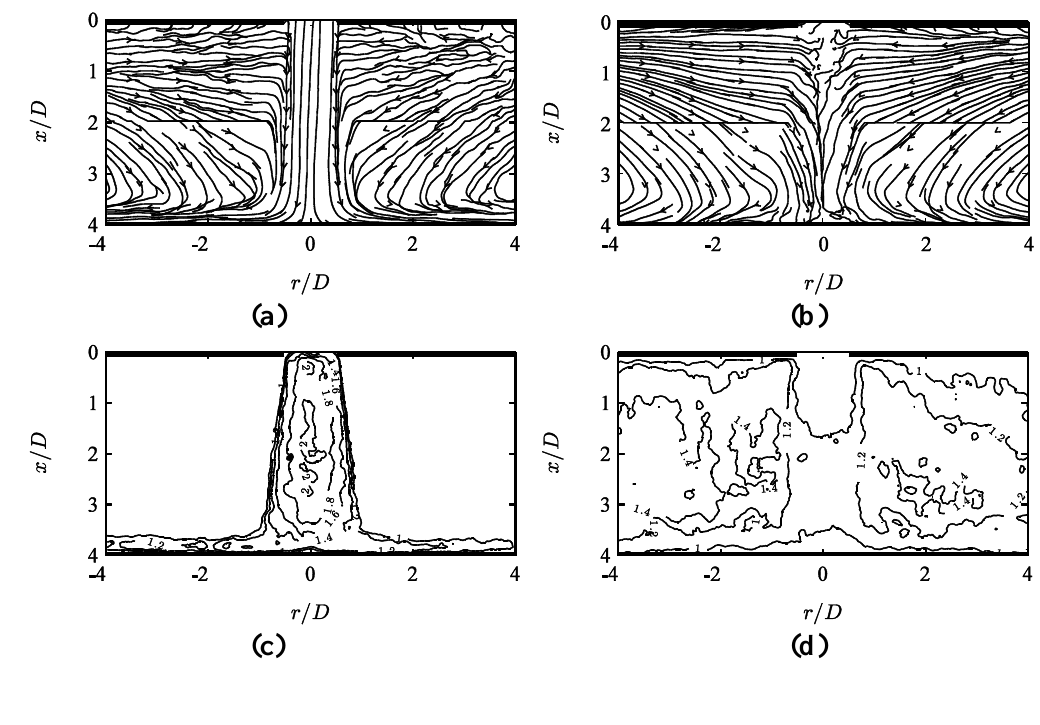
Figure 3. Conventional PIV results at pulse separation (a,c)  =  velocity jet region), and (b,d)  = 10  region): (a,b) time-averaged streamlines and (c,d) corresponding weighted peak ratio Q’ ( x , y